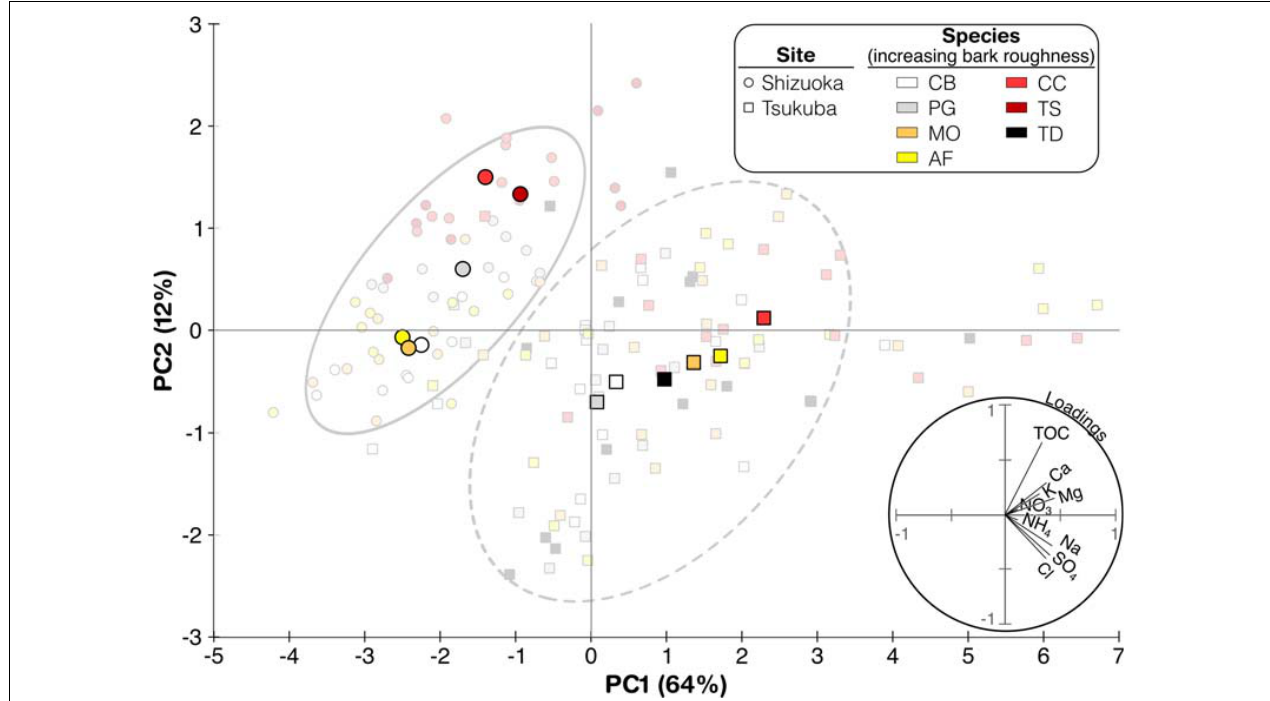
FIGURE 5 | Principal component analysis with TOC, pH, Cl − , NO 3 − , SO 42 − , Na + , NH 4 + , Mg 2 + , Ca 2 + , and K + concentrations measured in the Shizuoka site (solid line) and the Tsukuba site (dotted line). The arrows represent variable eigenvectors in the space plotted by the first two PCA axes. The projection of the lines along each axis indicates their relative